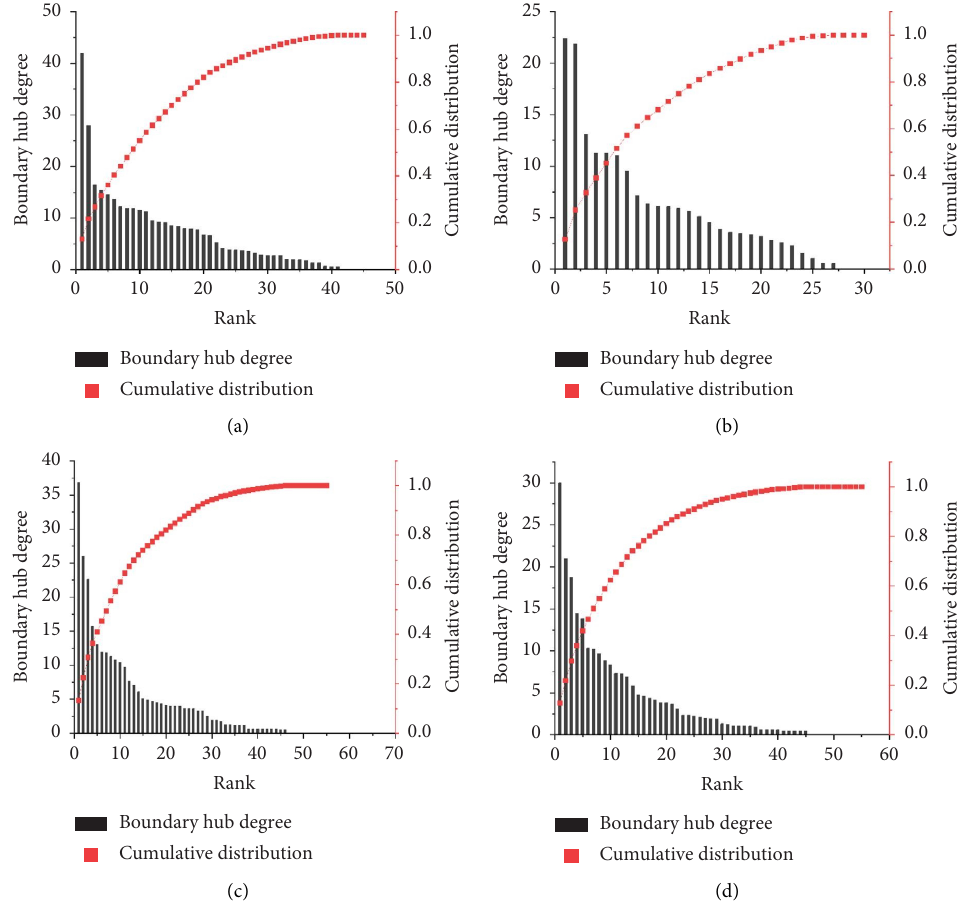
Figure 7: Pareto analysis diagram of boundary hub degree: (a) boundary hub degree of West Asia and North Africa community, (b) boundary hub degree of Russian community, (c) boundary hub degree Central and Eastern European community, and (d) boundary hub degree of China and Southeast Asian